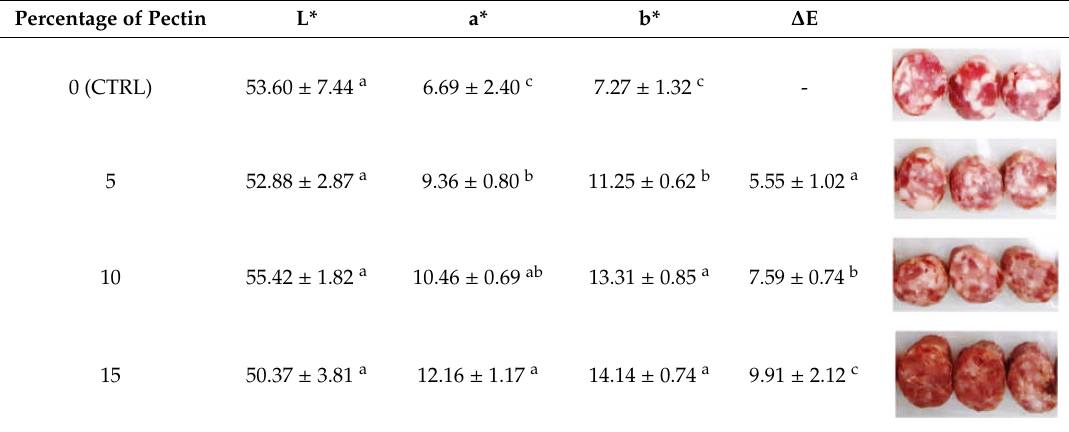
Table 2. Colour of dried Chinese sausage with added mango peel pectin at di ff erent levels. Percentage of